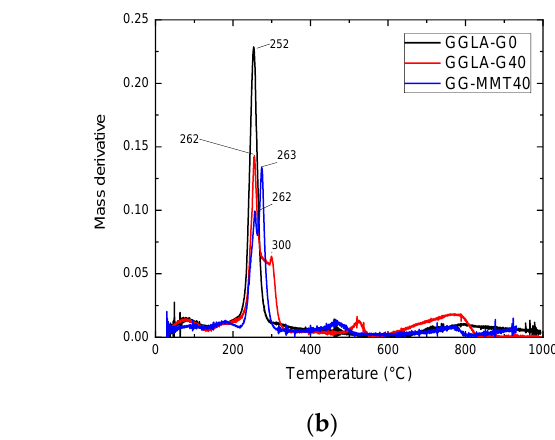
tion temperatures of the SPEs or NPEs, remained practically within the same range, i.e., between 124 and 174 °C for GG-MMT15 and GG-MMT20, respectively. 124 and 174 ◦ C for GG-MMT15 and GG-MMT20, respectively.